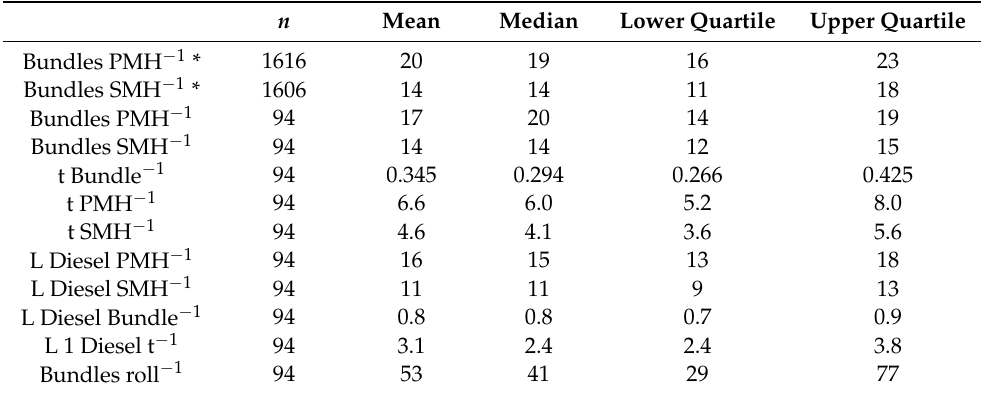
Table 2. Productivity and fuel/twine consumption.